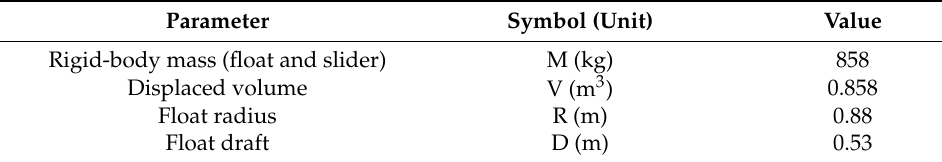
Figure 1. Test device diagram. Table 1. Model-scale wave energy converter (WEC) physical